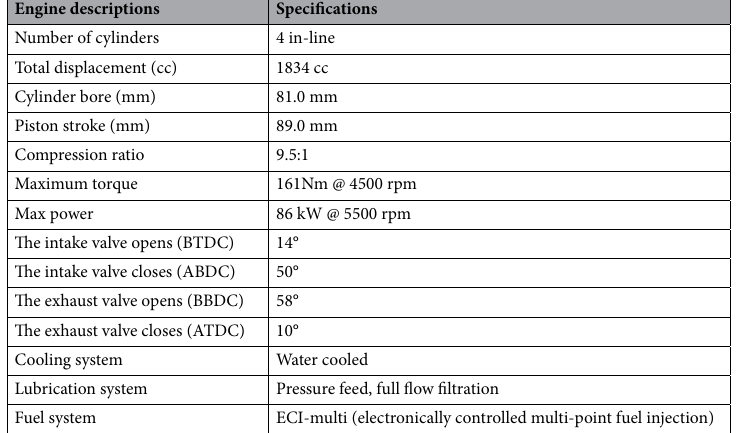
Table 1. Engine specifications.